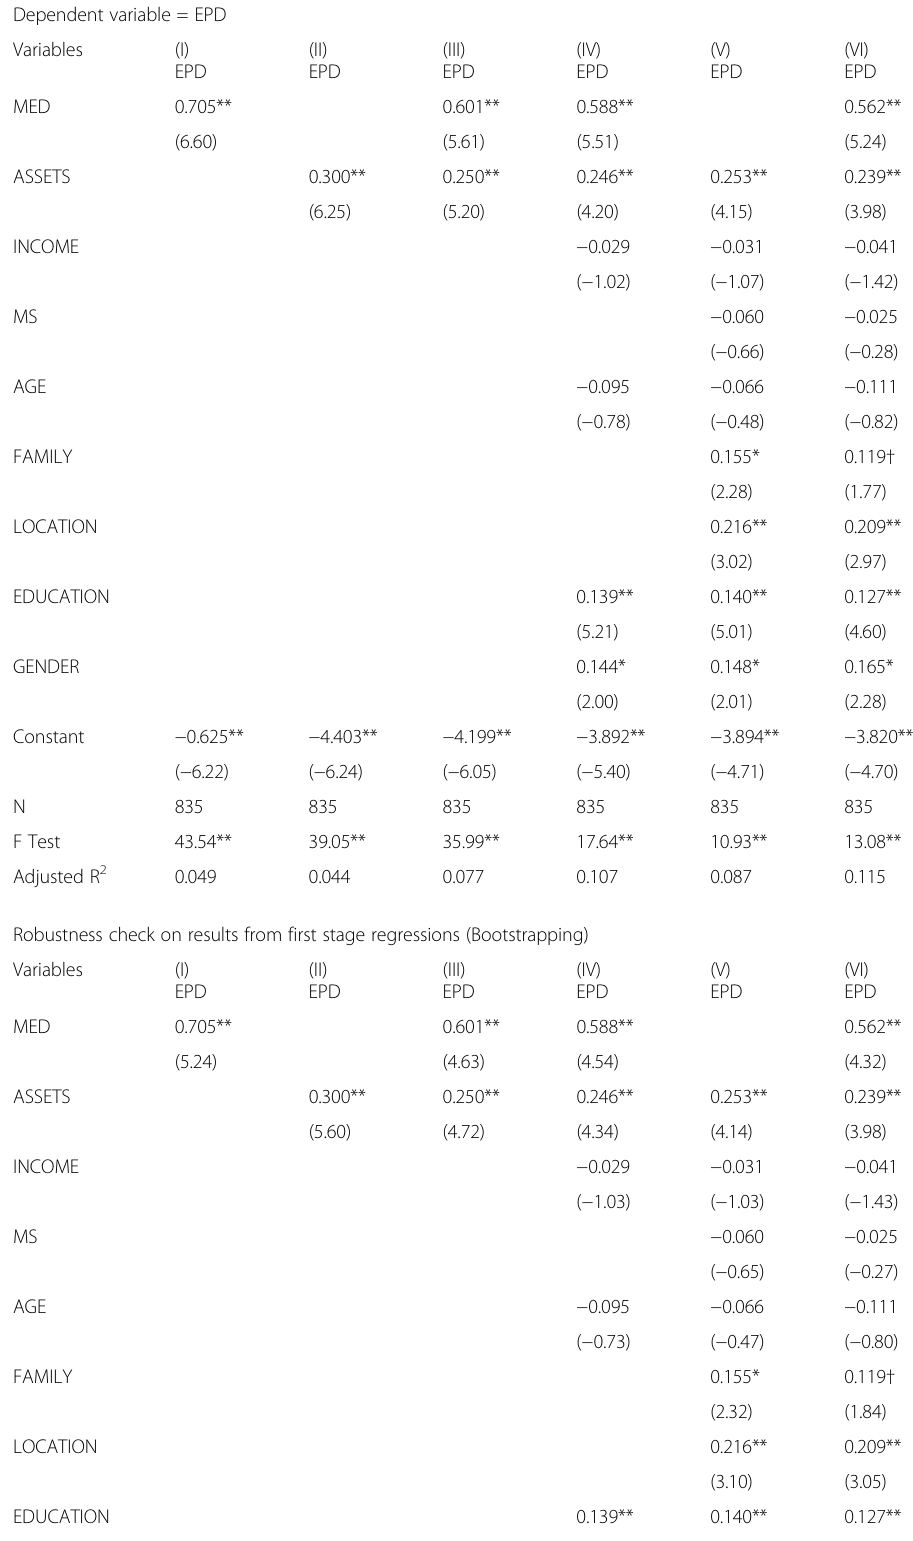
Table 3 Results from first stage regressions